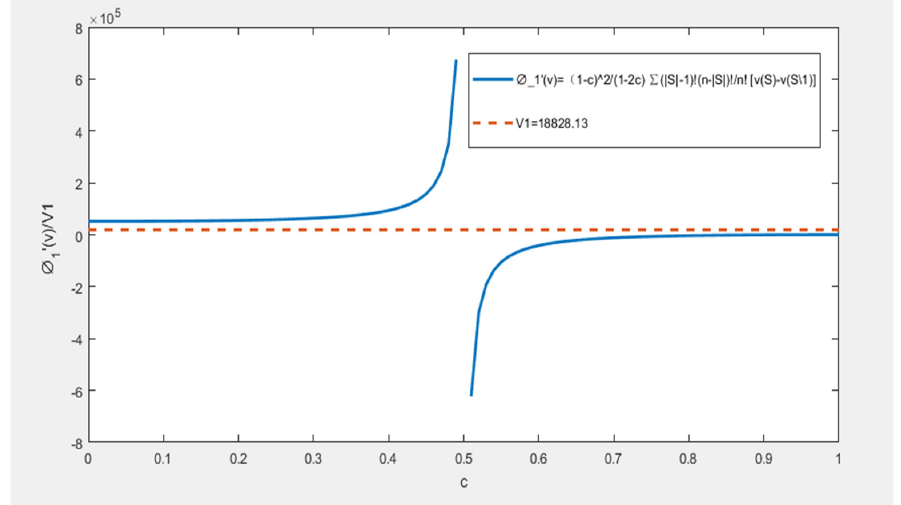
Figure 1. The Shapley value of China as an example.